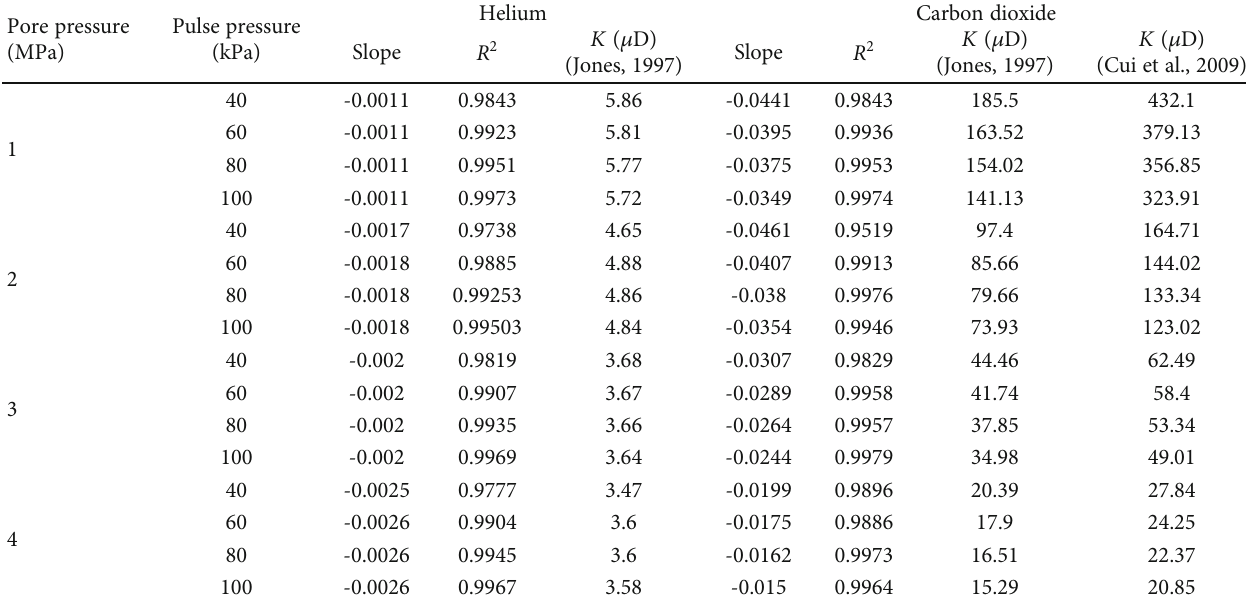
Figure 3: Typical curves of Δ P ð t Þ − t and ln ð Δ P Table 2: Permeability measurement results under di ff erent conditions in the experiment.